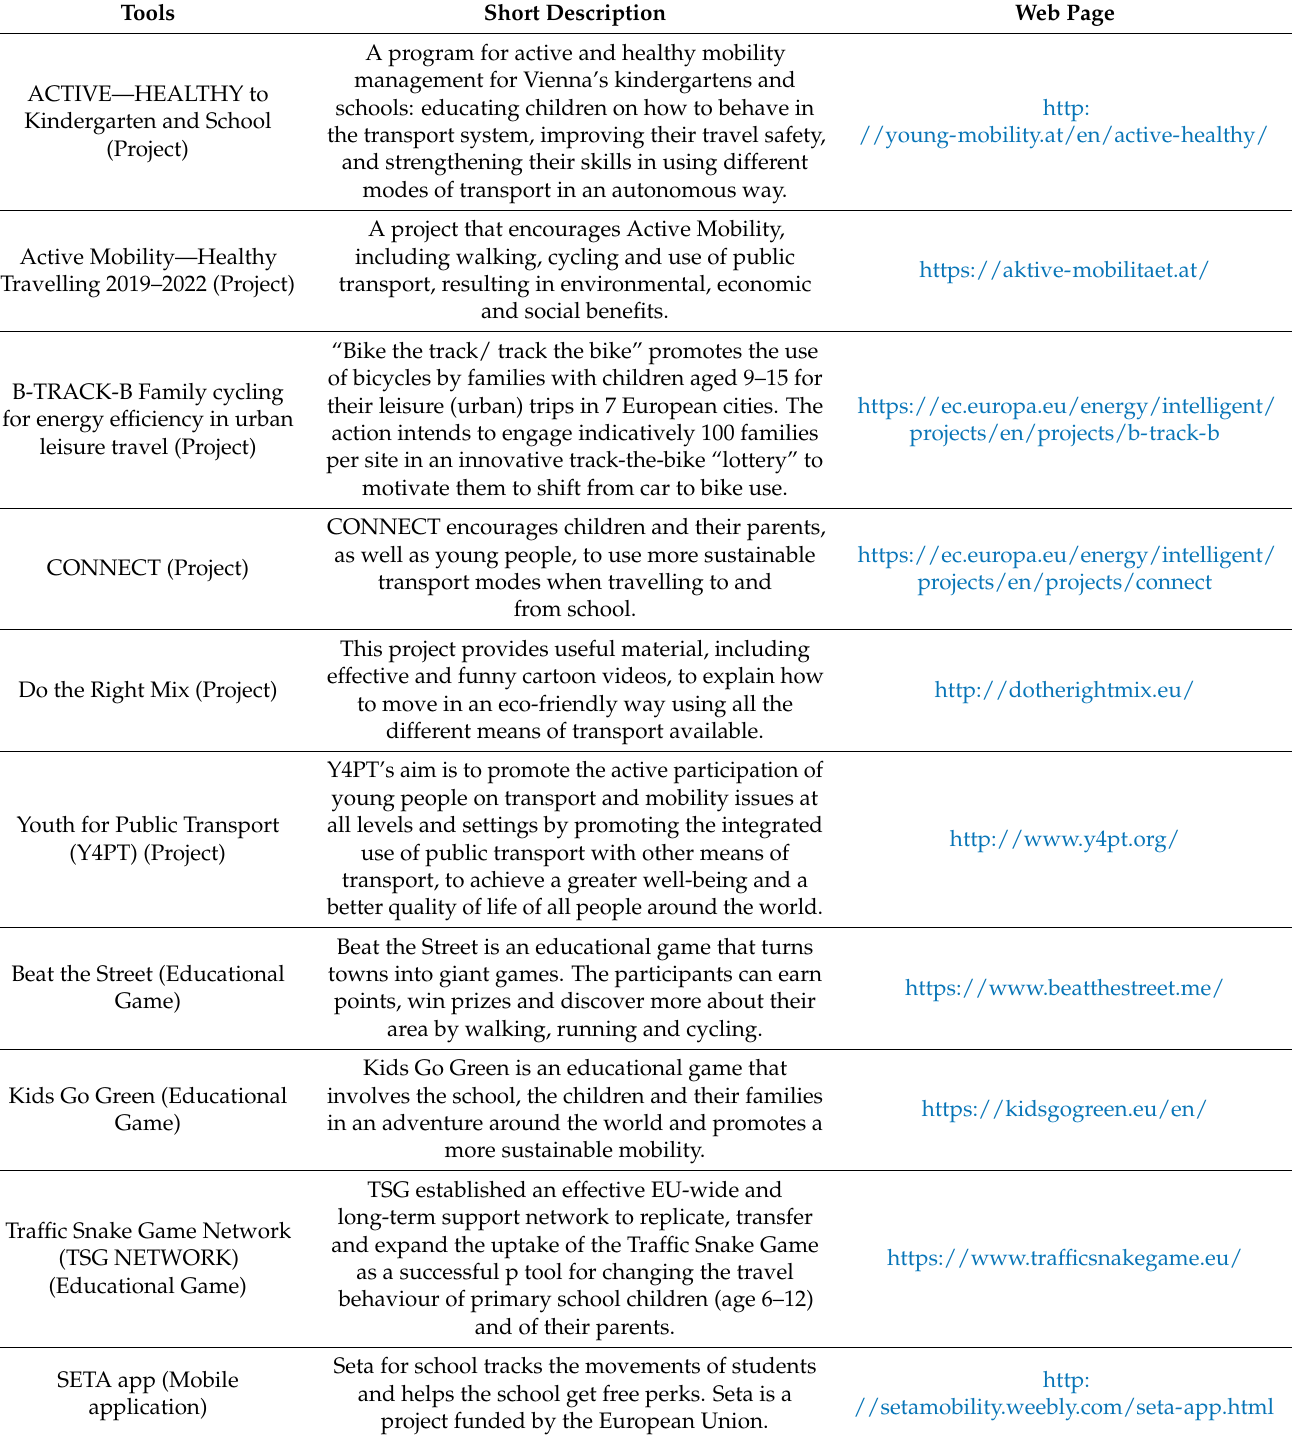
Table 1. Tools for educating pupils—adolescents in sustainable travel urban behavior.